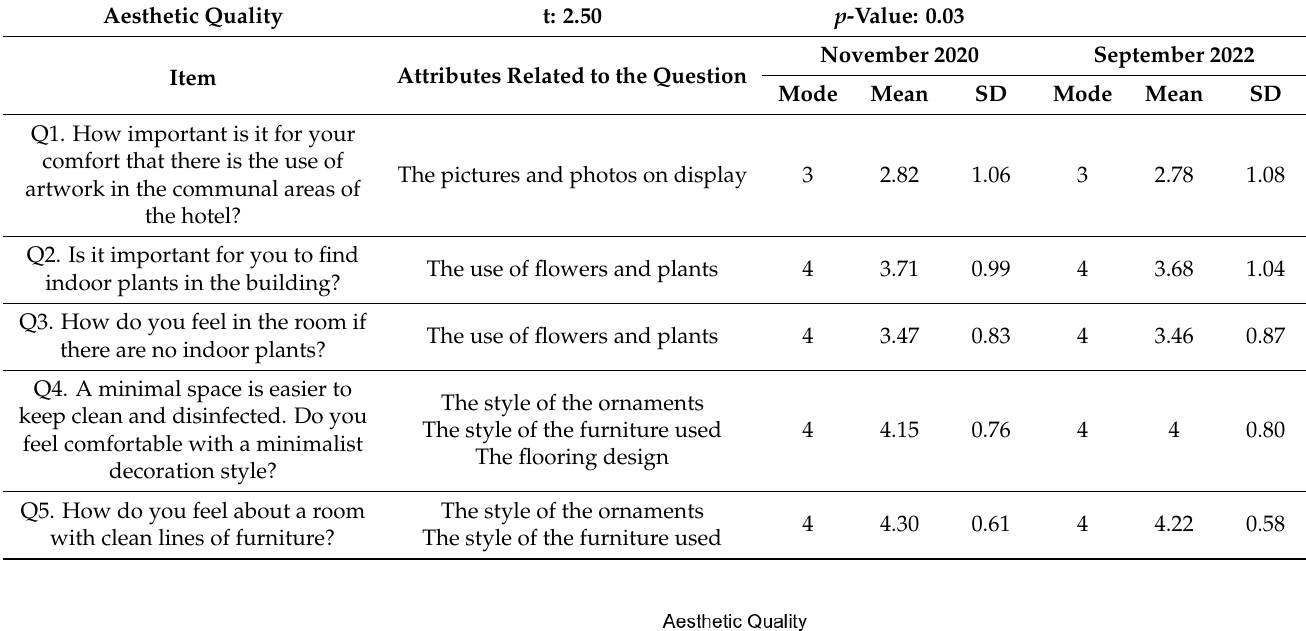
Table 2. Interval data analysis of the Aesthetic Quality dimension.